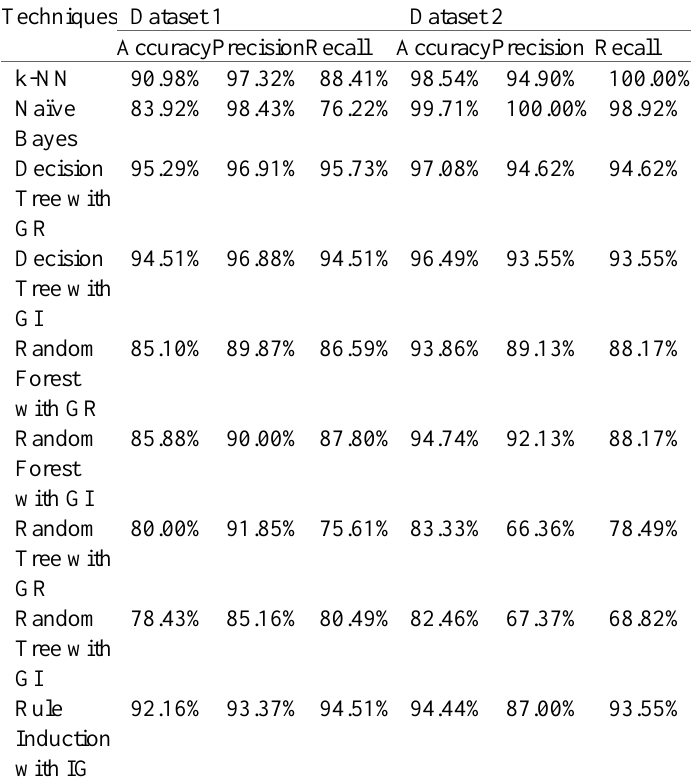
Comparison of datasets for Non-Technical Courses Predictors